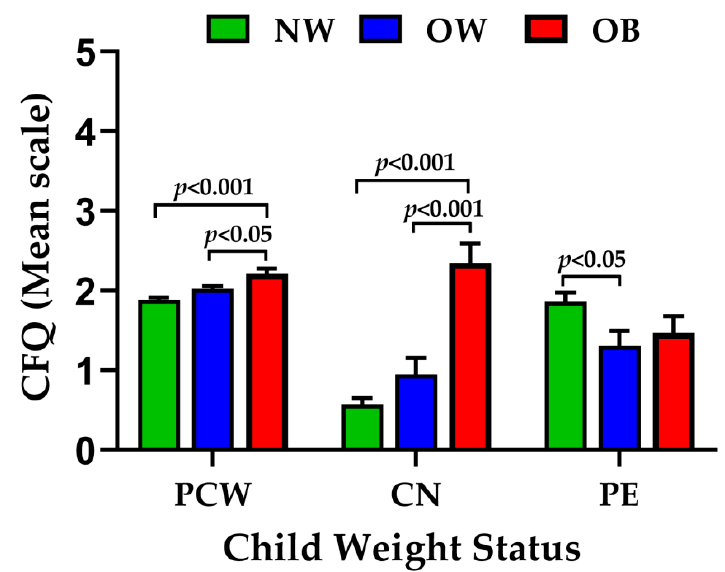
Figure 1. Bar graph showing the relation between the perceived child weight (PCW), parental concern (CN), and pressure to eat (PE) factors with the NW, OW, and OB participants. The values in the graph represent mean ± SEM.